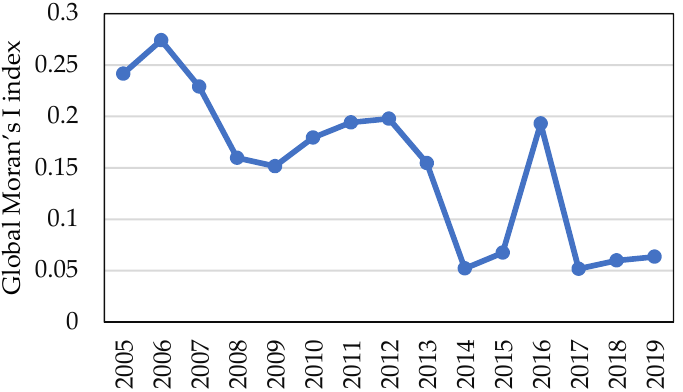
Figure 5. The coordination degree in regard to farmland transfer and CLGUE in China. No data—the data in Tibet, Taiwan, Hong Kong, and Macao are unavailable and unintegrated.